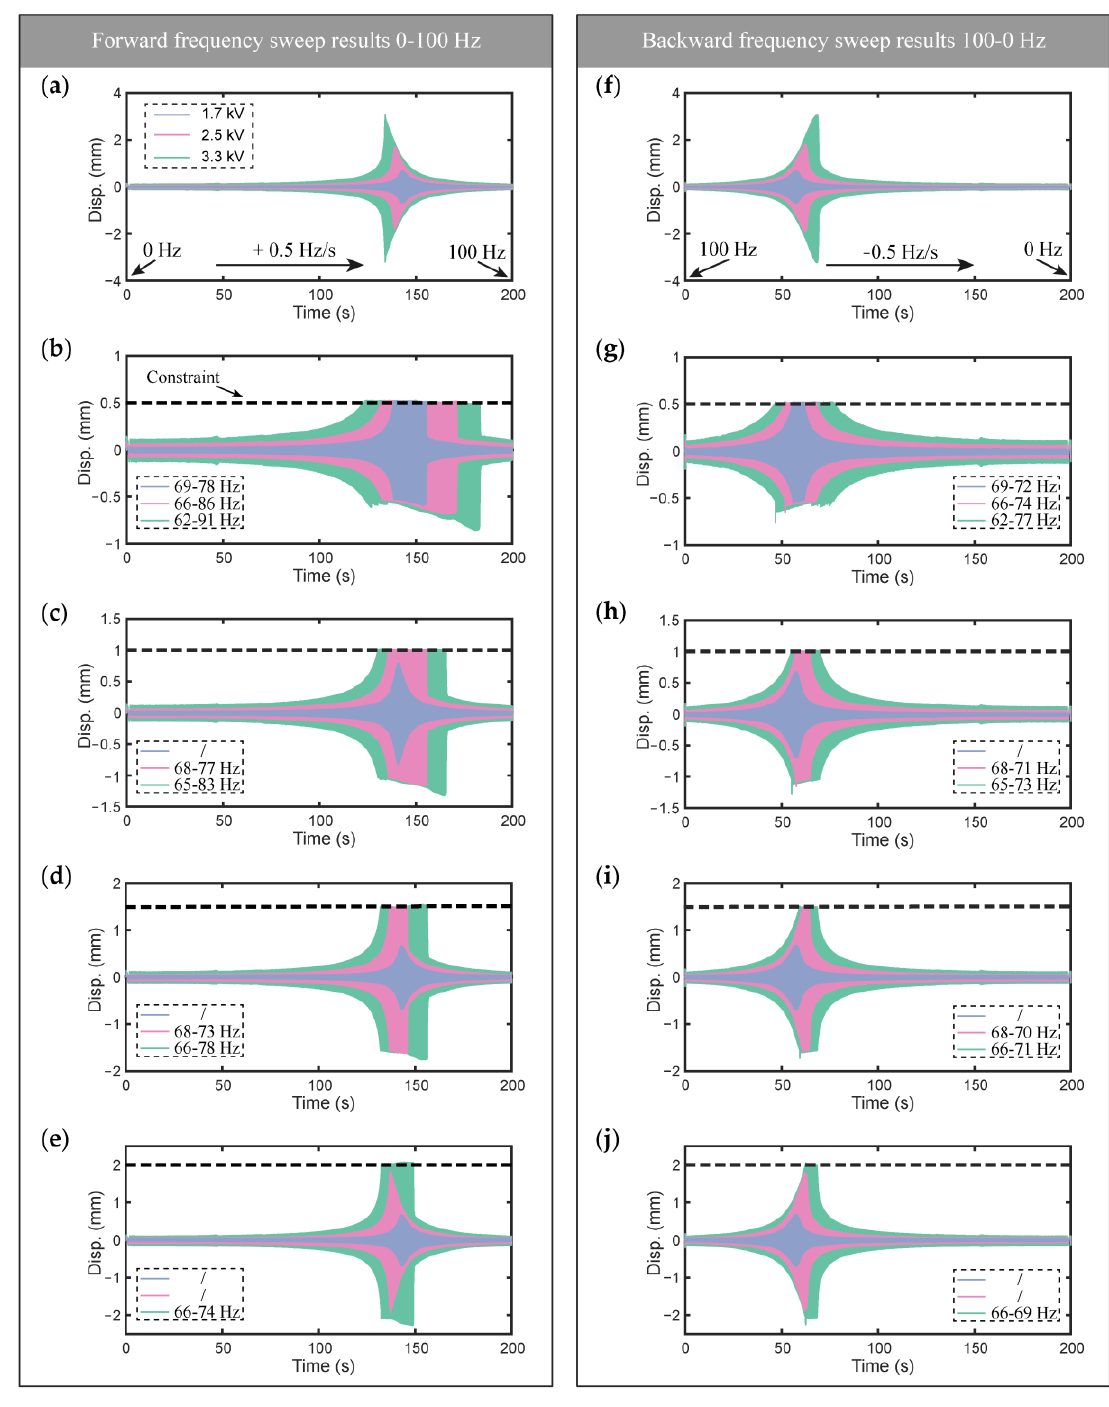
Figure 3. Forward and backward frequency sweep results of DCDEA and constraint with different gaps and under different actuation voltage amplitudes; ( a ) Forward frequency sweep result without constraint; ( b ) Forward frequency sweep result with constraint gap of 0.5 mm; ( c ) Forward frequency sweep result with constraint gap of 1 mm; ( d ) Forward frequency sweep result with constraint gap of 1.5 mm; ( e ) Forward frequency sweep result with constraint gap of 2.0 mm; ( f ) Backward frequency sweep result without constraint; ( g ) Backward frequency sweep result with constraint gap of 0.5 mm; ( h ) Backward frequency sweep result with constraint gap of 1 mm; ( i ) Backward frequency sweep result with constraint gap of 1.5 mm; ( j ) Backward frequency sweep result with constraint gap of 2.0